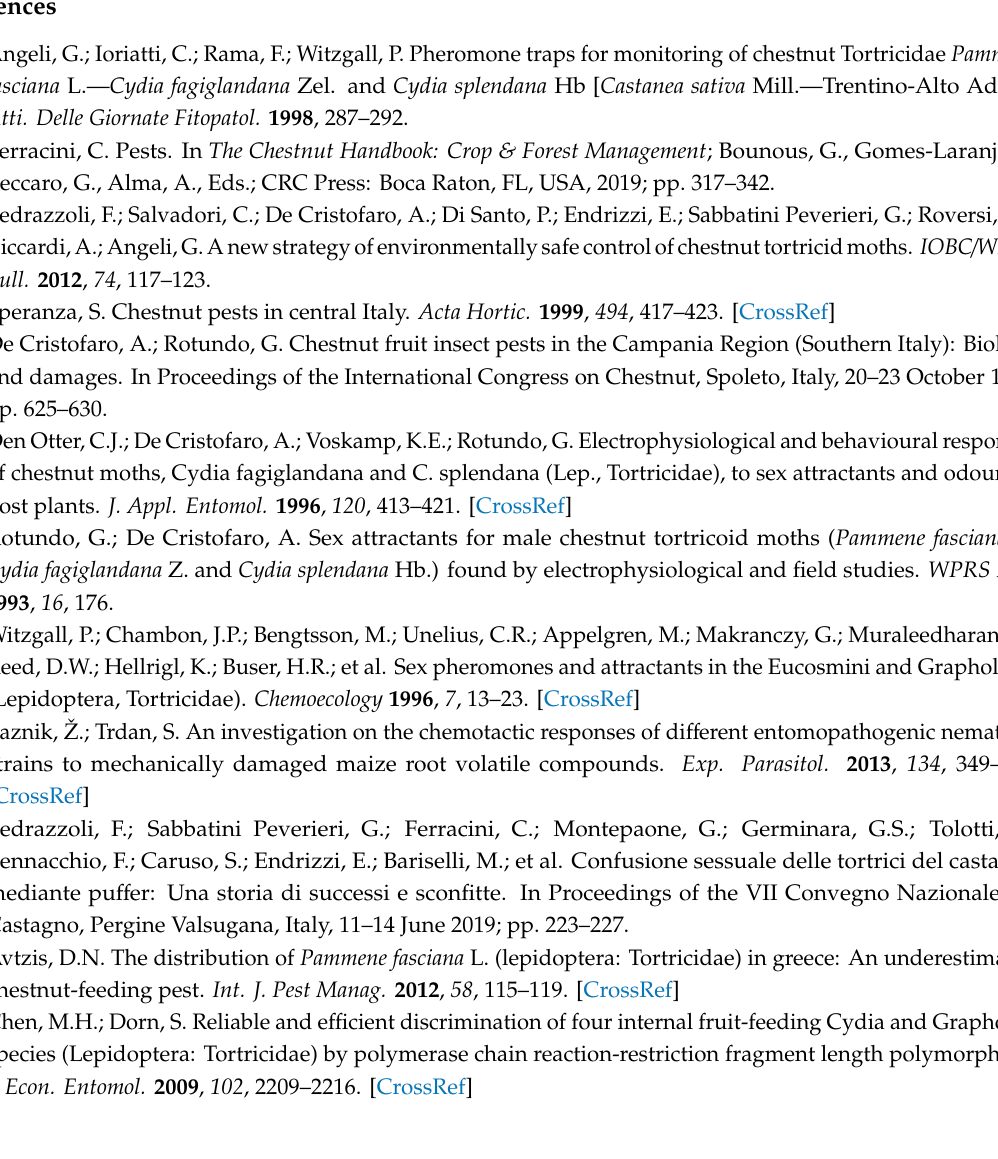
Figure S1: Location of study sites in northern Italy used for monitoring the population dynamics of the three chestnut tortricid species Pammene fasciana (L.), Cydia fagiglandana (Zeller), and Cydia splendana (Hübner), Table S1: Sampling sites monitored in the present